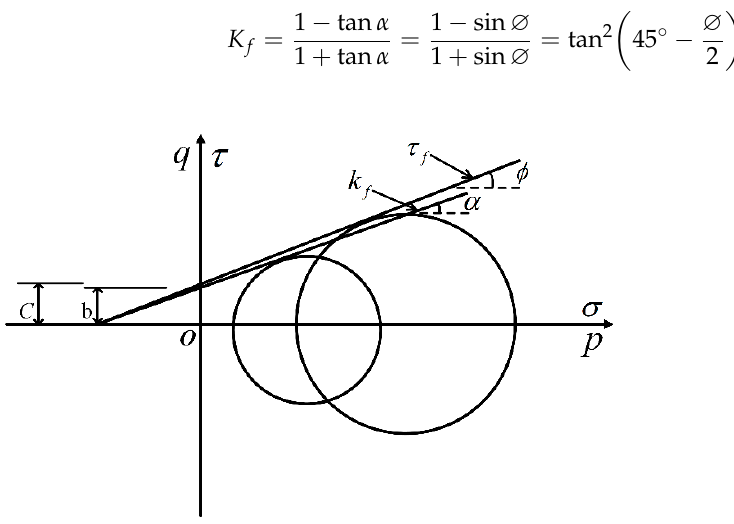
Figure 11. Illustration of 𝐾 (cid:3033) line and 𝜏 (cid:3033) line. Figure 12 shows the 𝐾 (cid:3033) lines for PP fiber-reinforced FAS specimens. With the rise of fiber content, it is found that the slope of the critical stress line for specimens with the same fiber length has a gradual increase. The slope of the critical stress line increases from 0.39 to 0.47 when the 𝐾 (cid:3033) lines of non-reinforced FAS specimens are compared with those PP fiber-reinforced counterparts. In addition, it can be seen from the figure that the critical stress curves of PP fiber-reinforced FAS specimens are basically parallel to those of non-reinforced counterparts.